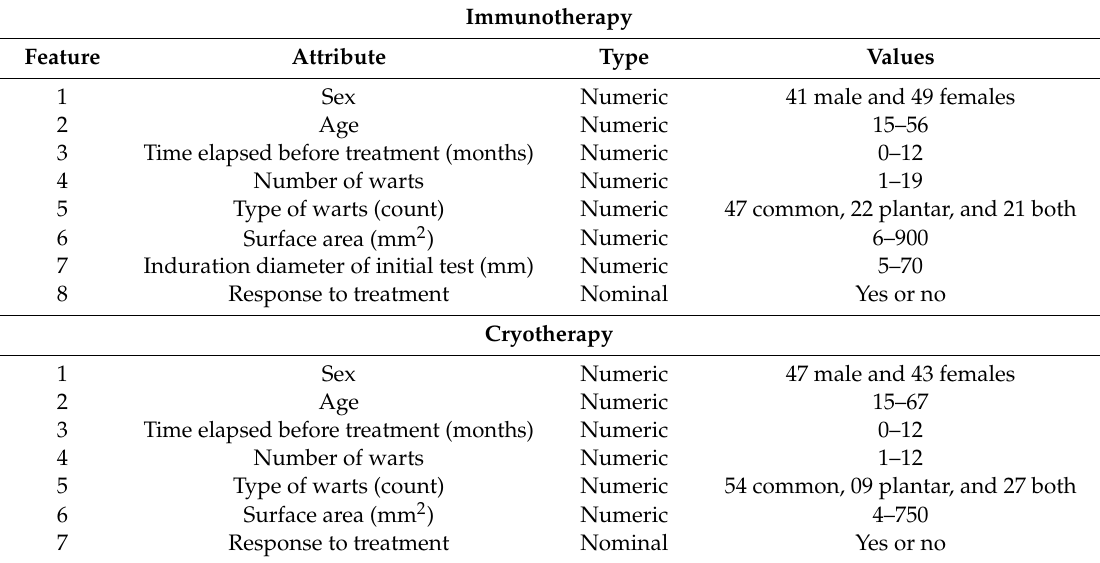
Table 2. Features in the original immunotherapy and cryotherapy